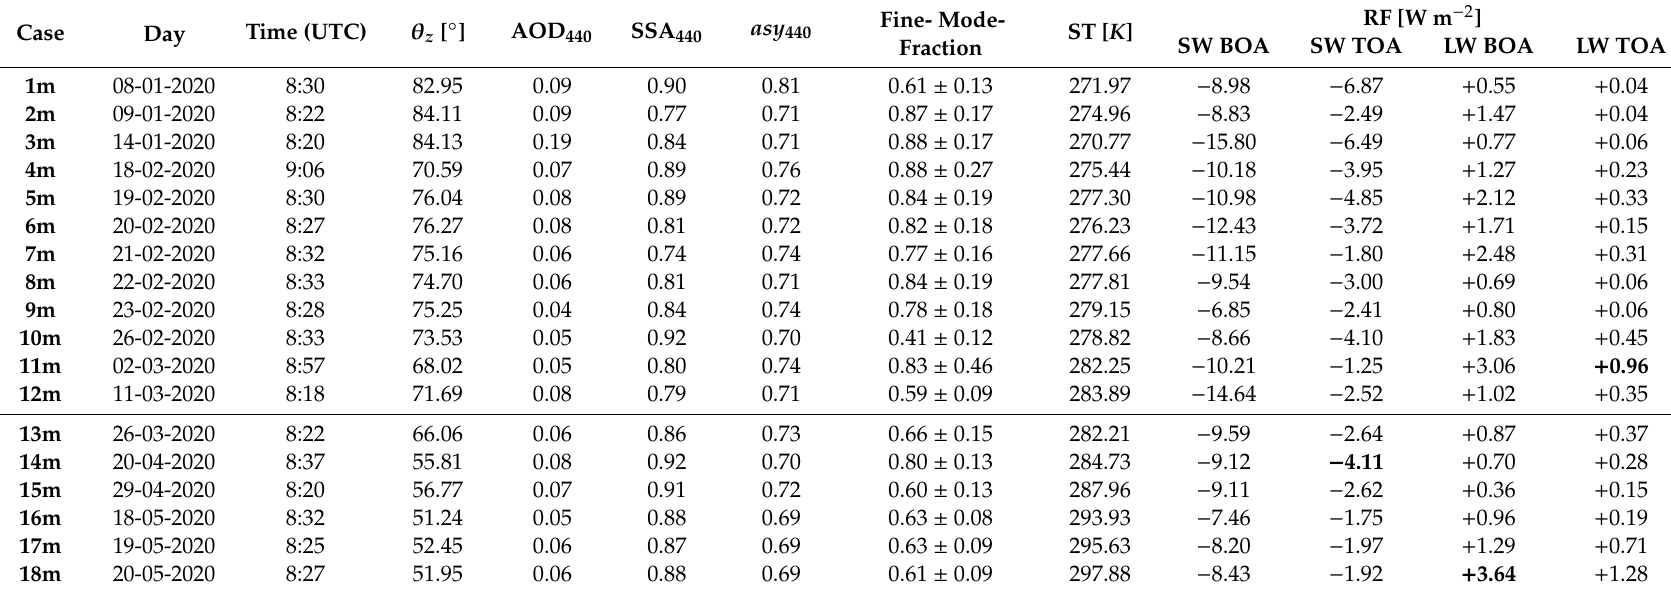
Table 4. Aerosol radiative forcing (last four columns), estimated for 28 di ff erent mornings without presence of mineral dust in the atmosphere, at the BOA and the TOA for the LW and SW. Time refers to the ceilometer start time (all ceilometer measurements are of a duration of 2 h). Fine-mode-fraction is shown together with its standard deviation, provided by AERONET. The letter “m” in the case number denotes that these are morning cases. Radiative forcing estimates considered as outliers by the boxplots (see Figures 5 and 6) are marked in